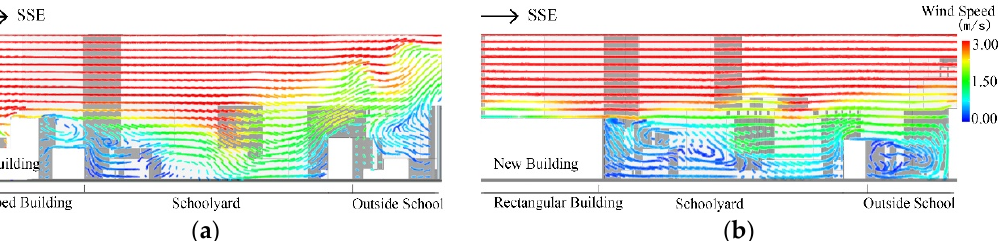
Figure 14. The north-south wind section of Changjiang Road Primary School in summer: ( a ) 1990s; ( b ) 2010s. As shown in Figures 15 and 16, the new lift-up style teaching building was constructed at Shanxi Road Primary School to provide more teaching room for students. This building form provides students with partly shaded space and classrooms. Consequently, the lift-up building served as an attractive way for school managers and designers to provide outdoor spaces and added teaching rooms in high-density cities [32]. As shown in Figure 16a,b, compared with the wind environment in the 1990s, the wind comfort area expanded at the bottom of the lift-up building in the 2010s. To verify the benefits of this architectural form for the pedestrian-level wind environment, the wind environments of the lift-up building and non-lift-up building in Shanxi Road Primary School were simulated. As shown in Figure 16b,c, the pedestrian-level wind of Shanxi Road Primary School with a non-lifted building weakened on the leeward side of the building in the summer. This indicated that the lifted building design could reduce the building’s obstruction of pedestrian-level airflow. In the winter, however, the lift-up design did not enhance the wind speed around the building, showing that the improvement to the pedestrian-level horizontal wind speed by the overhead layer related to the wind direction